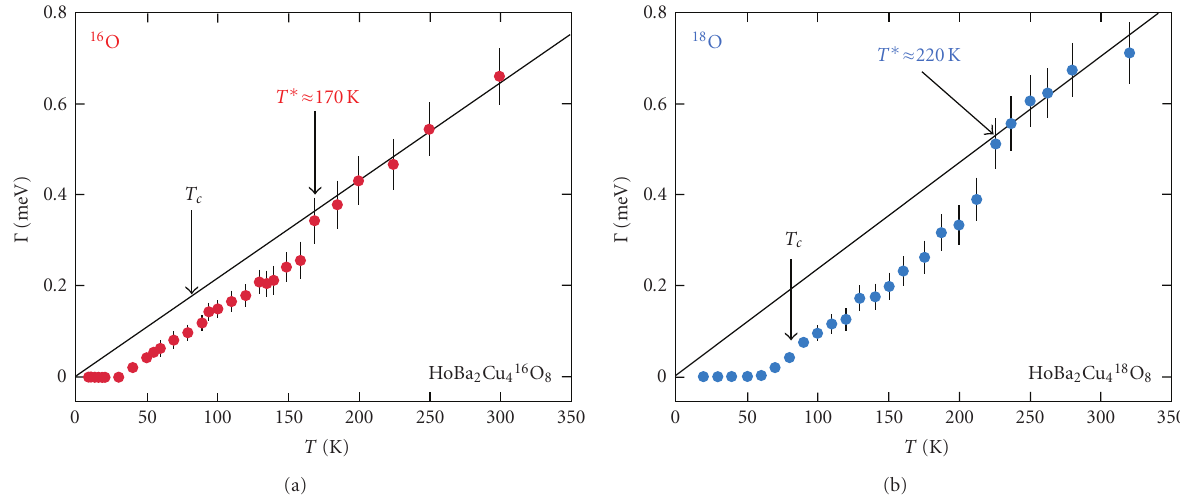
Figure 8: Temperature dependence of the intrinsic line width Γ (HWHM) corresponding to the Γ 3 → Γ 4 ground-state crystal field transition in oxygen-isotope exchanged HoBa 2 Cu 4 O 8 as determined from inelastic neutron scattering experiments. The solid lines correspond to the line width in the normal state calculated by the Korringa law, after